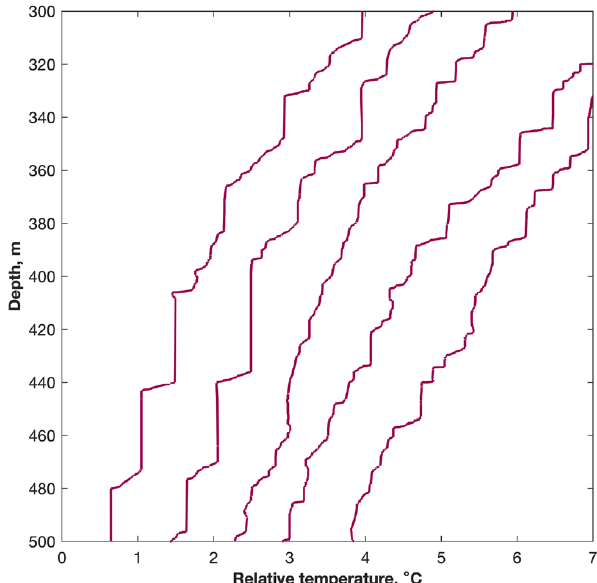
Figure 8. A selection of temperature profiles (presented as relative conservative temperature; ◦ C) recorded by the FP07 fast thermistor. Thermohaline staircases are visible at a variety of